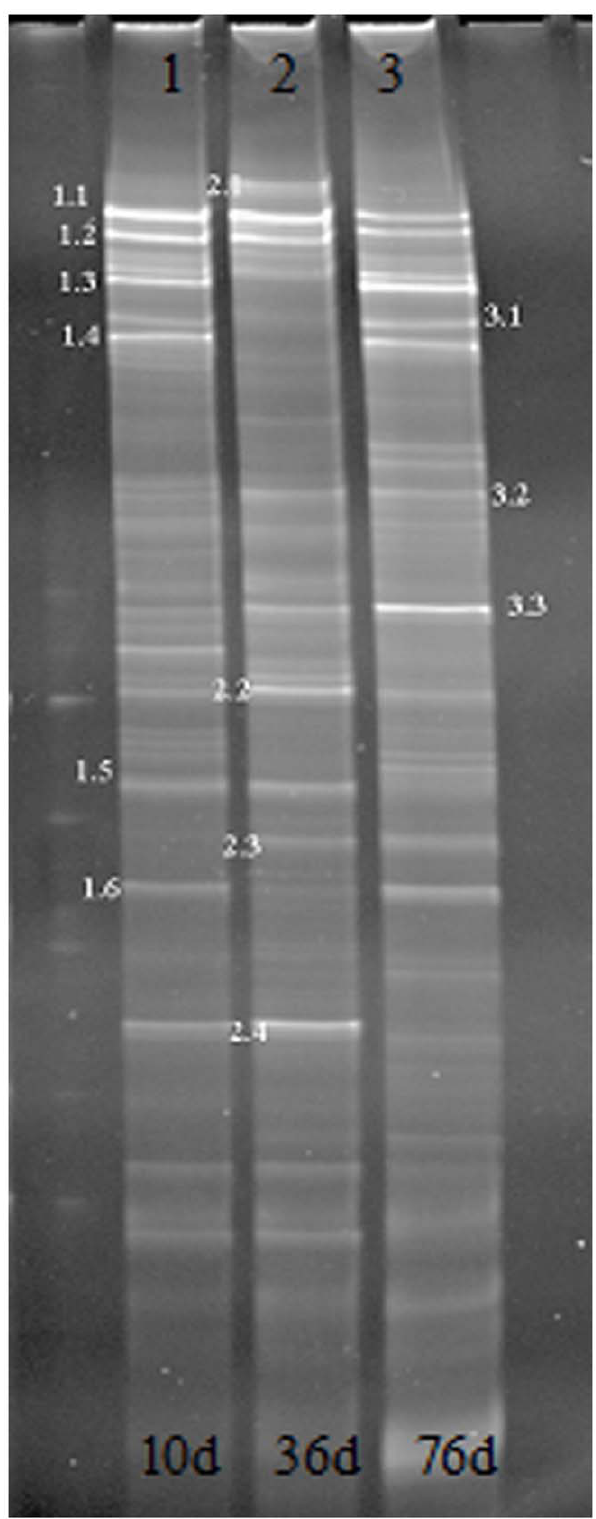
Figure 6. DGGE profiles of the 250-bp PCR fragment of 16S rDNA genes (V3 region) amplified from different biofilm samples.